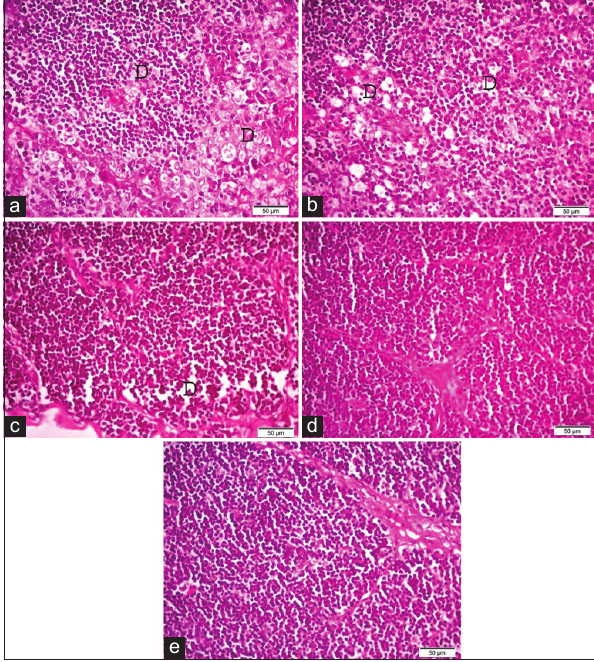
Figure-3: Photomicrographs of hematoxylin and eosin (H&E) stained sections of the bursa of Fabricius, (a) the bursa of Fabricius of G1 (broiler supplemented with 0.5 g/L Bacillus subtilis ) showing severe depletion of lymphoid follicles (D). (b) The bursa of Fabricius of G2 (broiler supplemented with 1.0* g/L B. subtilis ). (c) The bursa of Fabricius of G3 (broiler supplemented with 1.5 g/L B. subtilis ). (d) The bursa of Fabricius of G4 (broiler supplemented with 2.0 g/L B. subtilis ). (e) The bursa of G5 (control group). H&E. (40×). Bar 50 µ m.